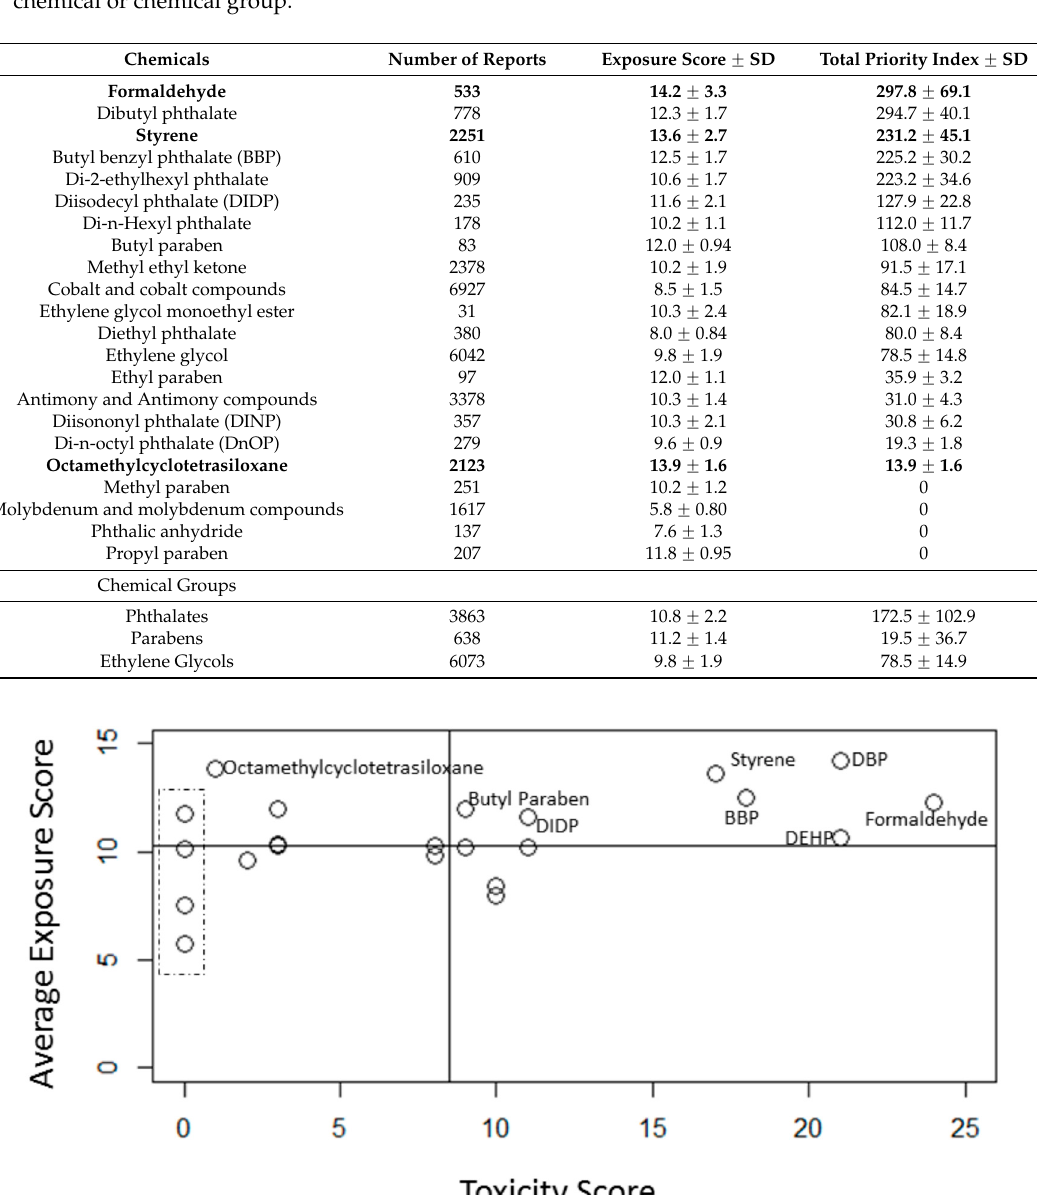
Table 3. Exposure scores and total priority indices for the CSPA chemicals considered in this framework. Chemicals are sorted based on total priority index. The three chemicals with the highest exposure scores are in bold. Standard deviations (SD) represent the variability in scores or indices within each chemical or chemical group.